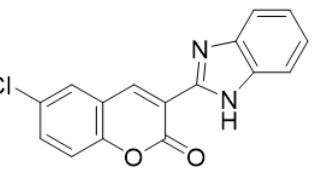
Figure 7. Chemical structure of 3-(1 H -benzo[ d ]imidazol-2-yl)-6-chloro-2 H -chromen-2-one.